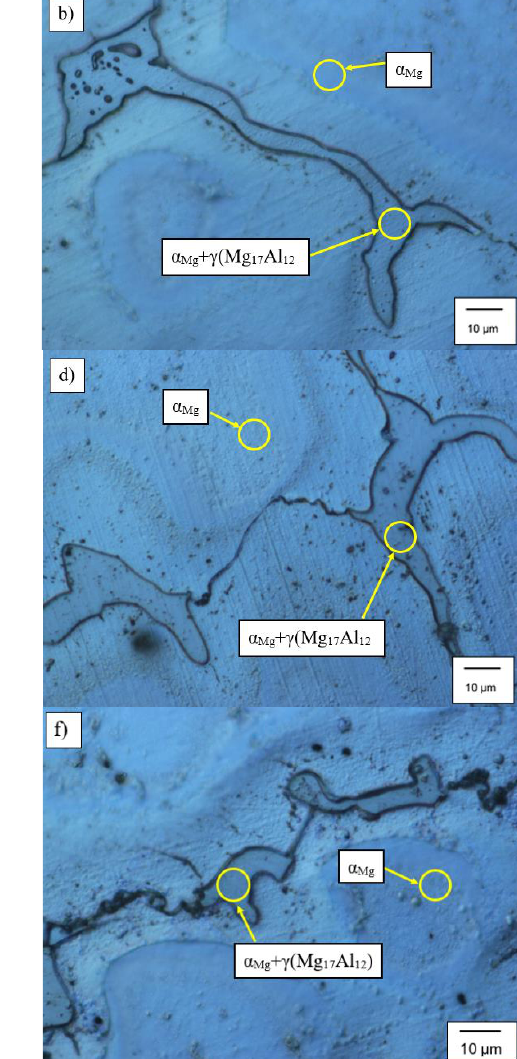
Figure 3. Microstructure of alloy: ( a , b ) — base magnesium alloy AZ91; ( c , d ) — modified magnesium alloy AZ91 with 0.3 wt % of Zr and ( e , f ) — modified magnesium alloy AZ91 with 0.6 wt % of Zr.